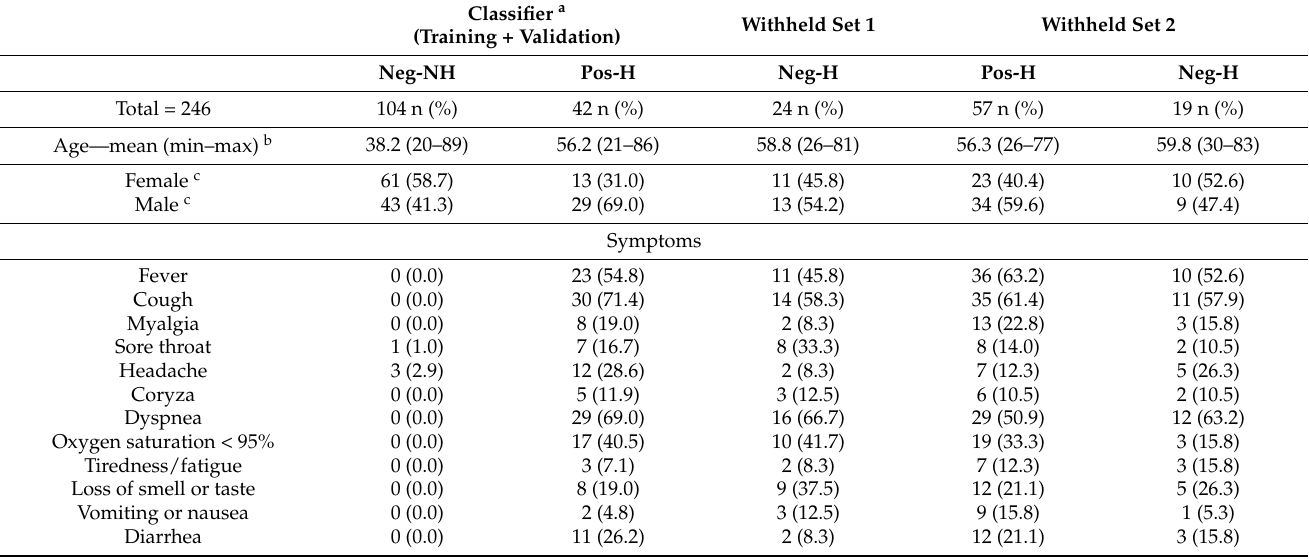
Table 1. Clinic and demographic information of individuals recruited for the study, including SARS- CoV-2-negative non-hospitalized subjects (Neg-NH) and SARS-CoV-2-positive hospitalized subjects (Pos-H), used for model building and evaluation. Withheld Sets 1 and 2 containing symptomatic SARS-CoV-2-negative hospitalized subjects (Neg-H) are also